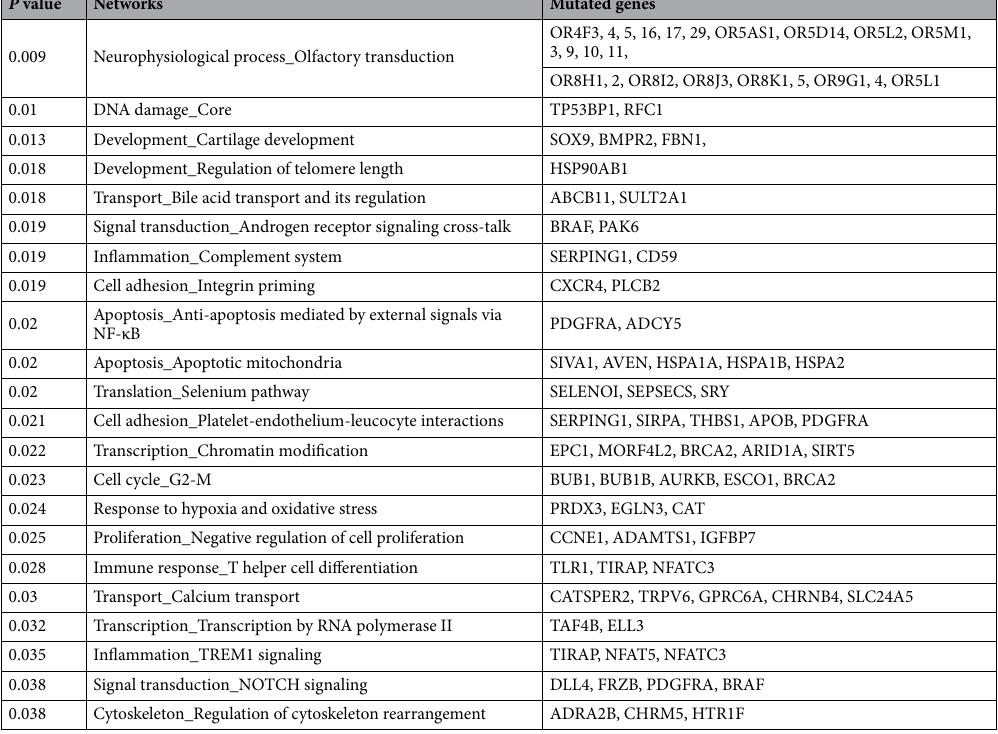
Table 2. Common exon mutations in MHCF1 and MHCF5 cells and their related signaling networks.